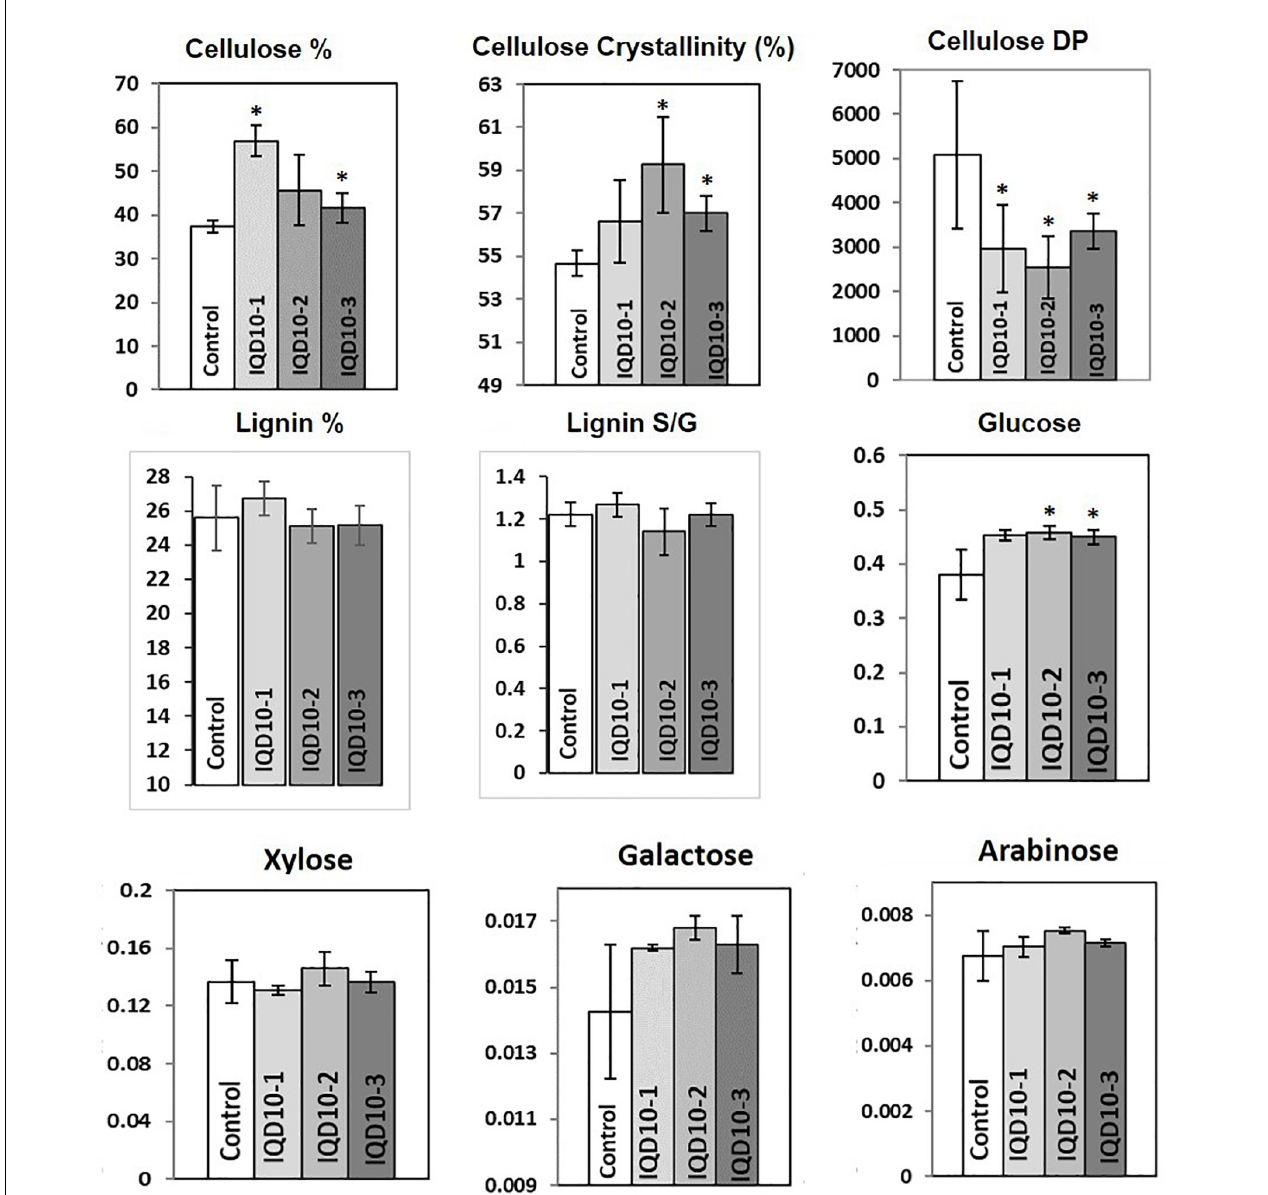
FIGURE 8 | Cell wall characteristics of PdIQD10 RNAi lines. Wet chemistry analysis of cellulose content, NMR analysis of cellulose crystallinity, GPC analysis of cellulose DP, MBMS analysis of lignin content and S/G ratio, and analysis of sugar composition of cell walls in control and three independent PdIQD10 RNAi lines. Data represent means ± SD ( n = 3–7). ∗ Indicates statistically significant, p ≤ 0.05 based on Student’s t